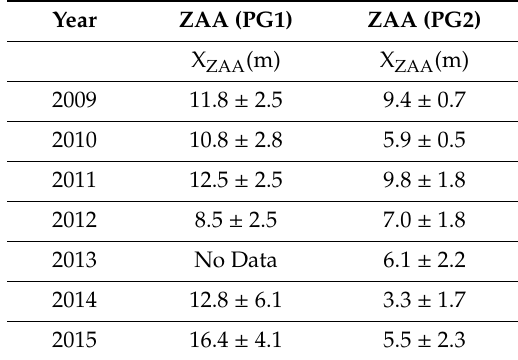
Table 5. Zero thermal annual amplitude depth (ZAA) at boreholes PG1 and PG2.